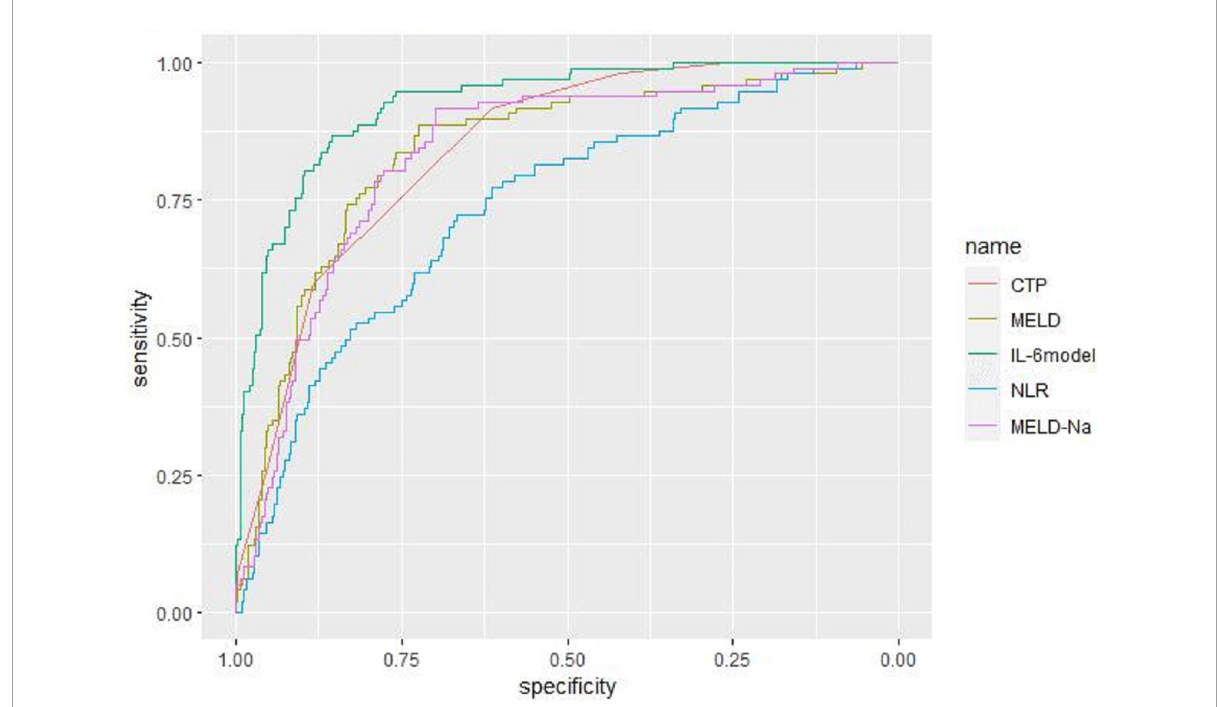
FIGURE5 The ROC curves and comparisons of prognostic scores for